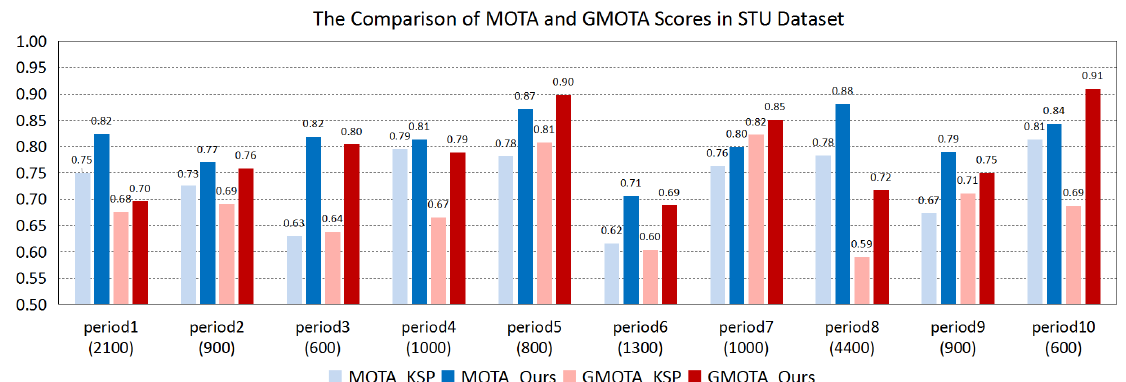
Figure 11. The comparison of MOTA and GMOTA scores between original KSP and our proposed KSP-AF in STU dataset: (1) 70%Color+50%Number is provided for KSP-AF tracking while original KSP considers neither of them; (2) both MOTA and GMOTA scores are clearly improved in KSP-AF compared to original KSP; (3) numbers in brackets are the frame lengths of each period respectively.